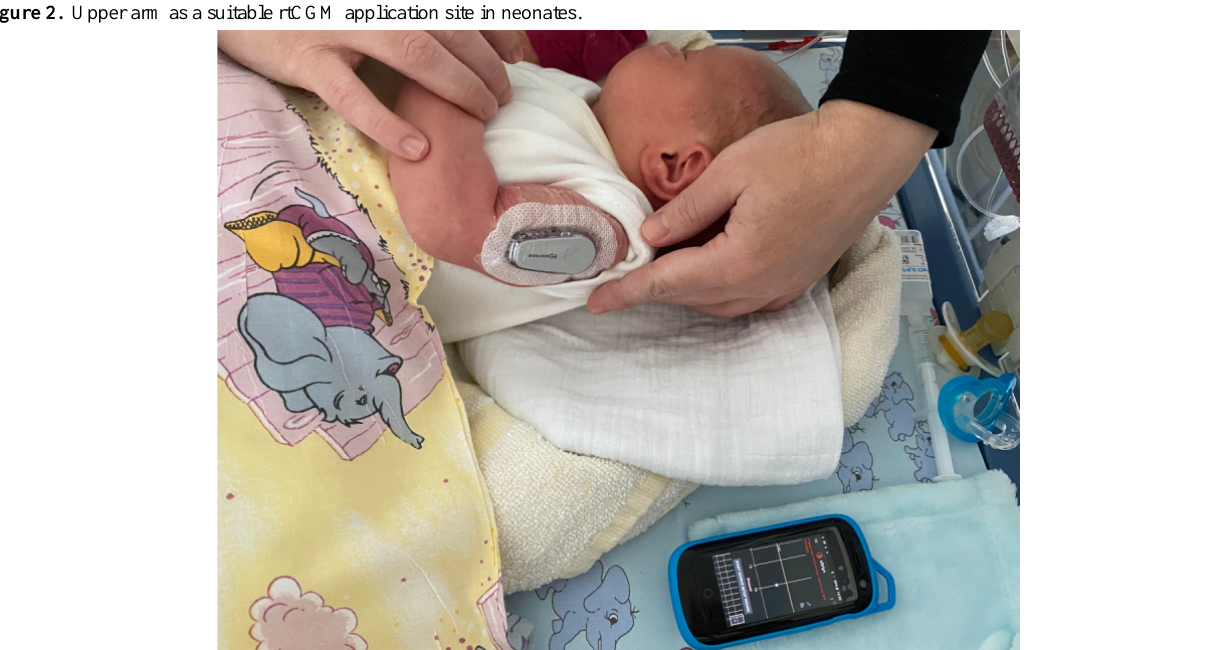
Figure 2. Upper arm as a suitable rtCGM application site in